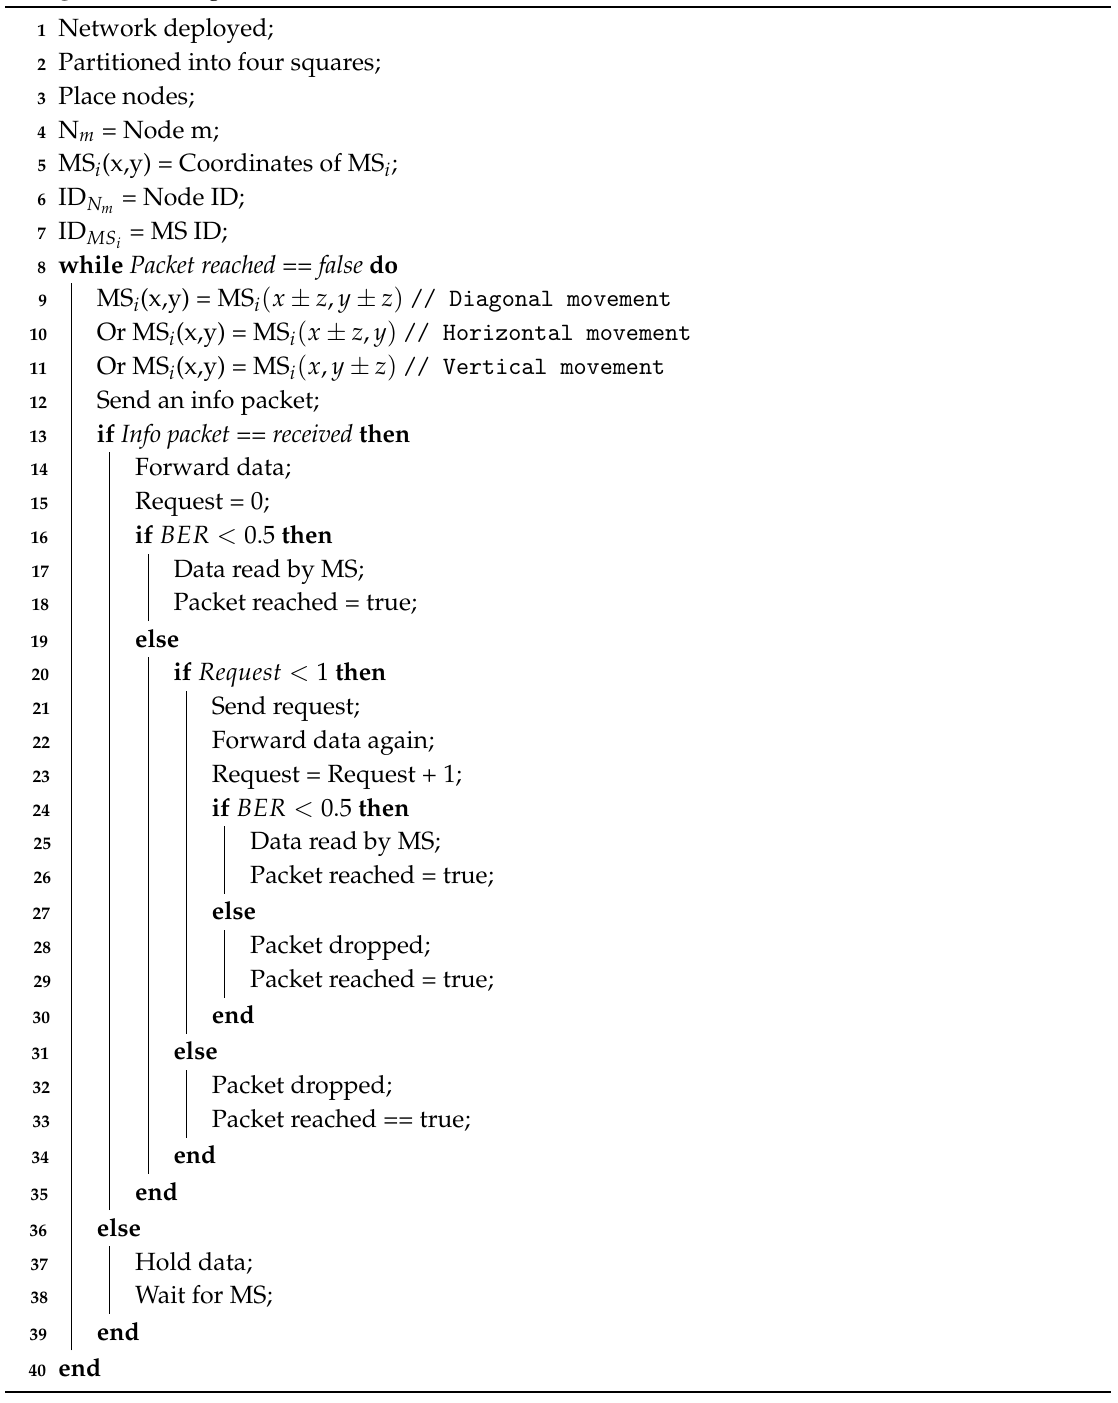
Algorithm 1: Algorithm for the CoSiM-RPO